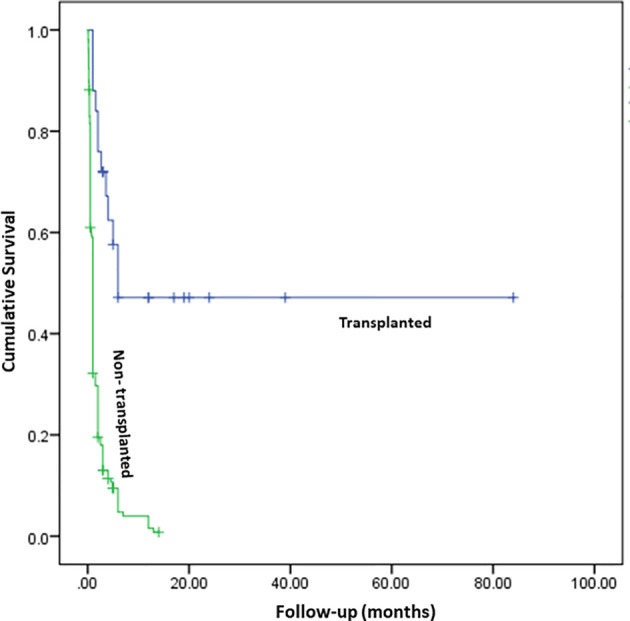
Survival curve comparing the outcome of children who underwent HSCT (n=23) and children who were not transplanted (n=213), p < 0.001 (Log Rank Mantel-Cox). Total person follow-up months—629.13 months.